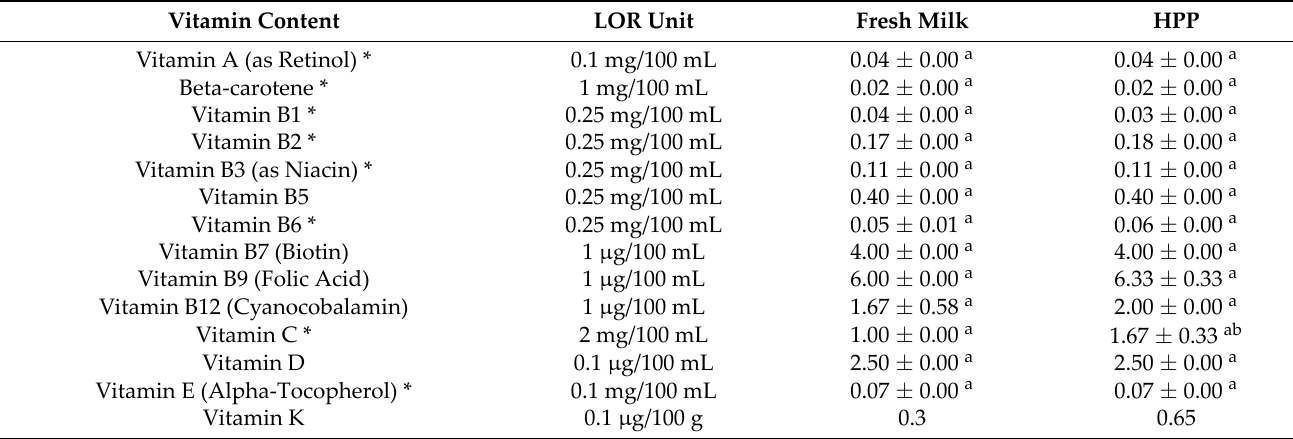
Table 2. Effects of HPP on vitamin content of fresh milk.